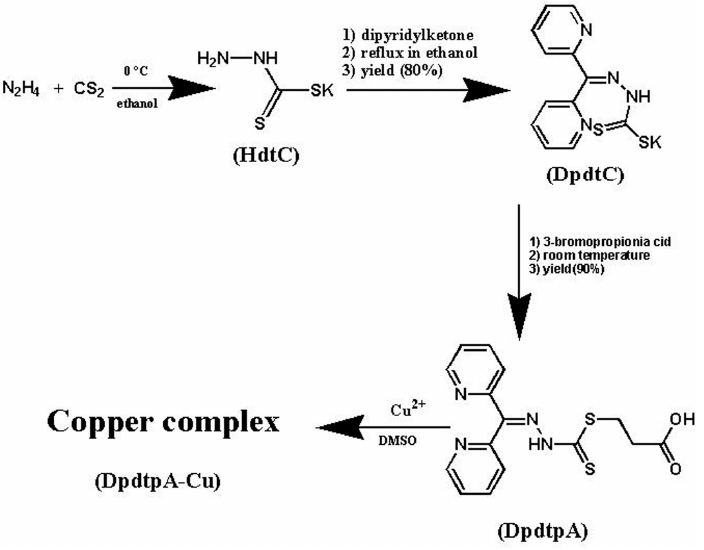
Figure 1. The synthetic rout of DpdtpA and its copper complex.